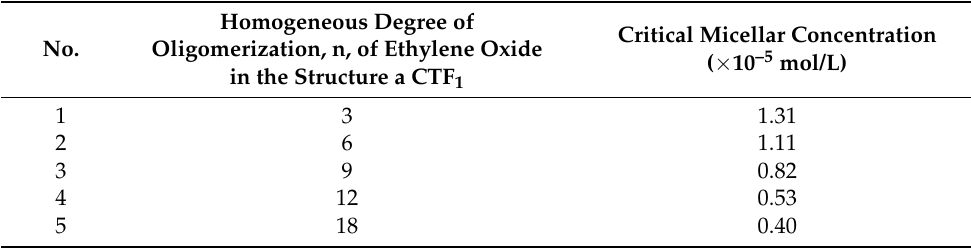
Table 4. Critical micellar concentration of the phase-transfer catalyst homogeneous N , N -dimethyl- N -